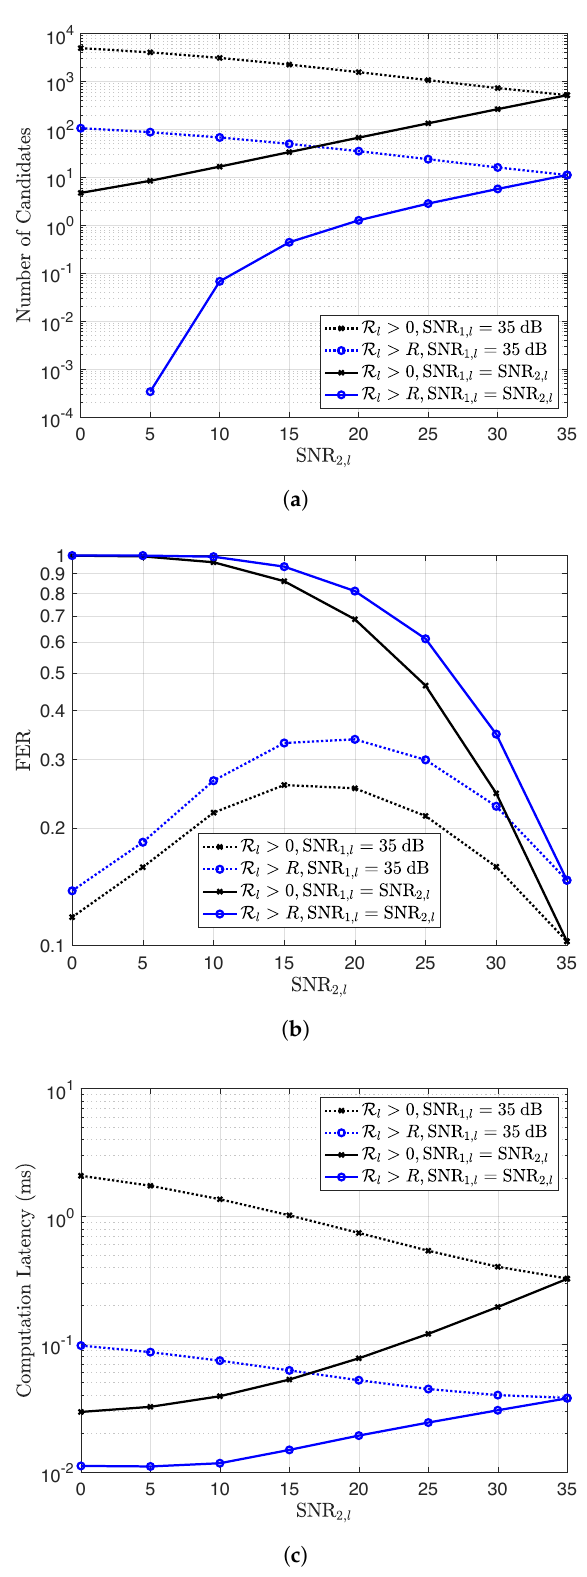
Figure 2. The performance applying condition R l ( h l , a l ) > R , compared with condition R ( h ) > 0. ( a ) Number of candidates; ( b ) frame error rate (FER); ( c ) computational l l , a l